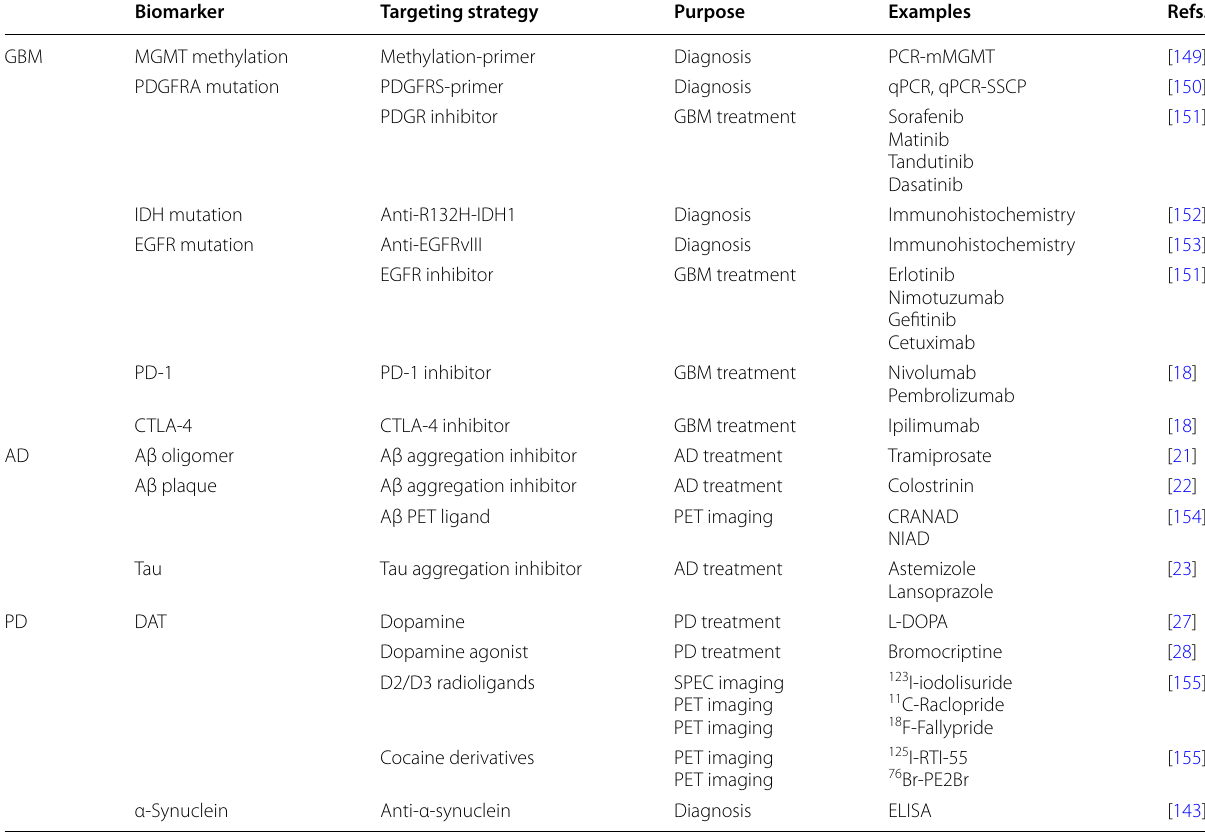
Table 1 List of CNS diseases and current strategies targeting the disease hallmarks Biomarker